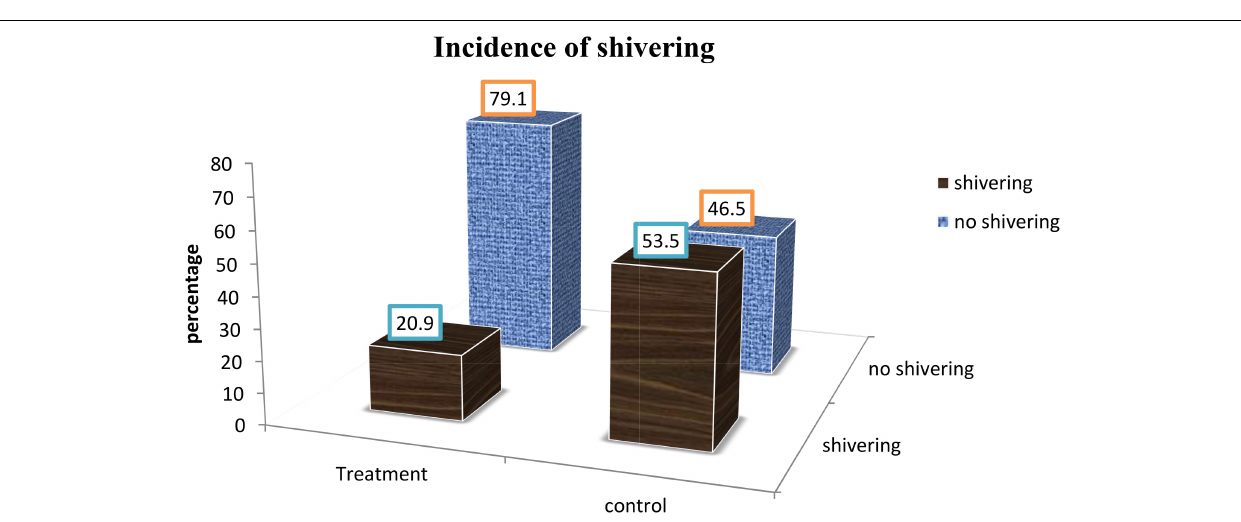
FIGURE 3 | Incidence of shivering between treatment and control group in Dilla University Referral Hospital, 2021/22.